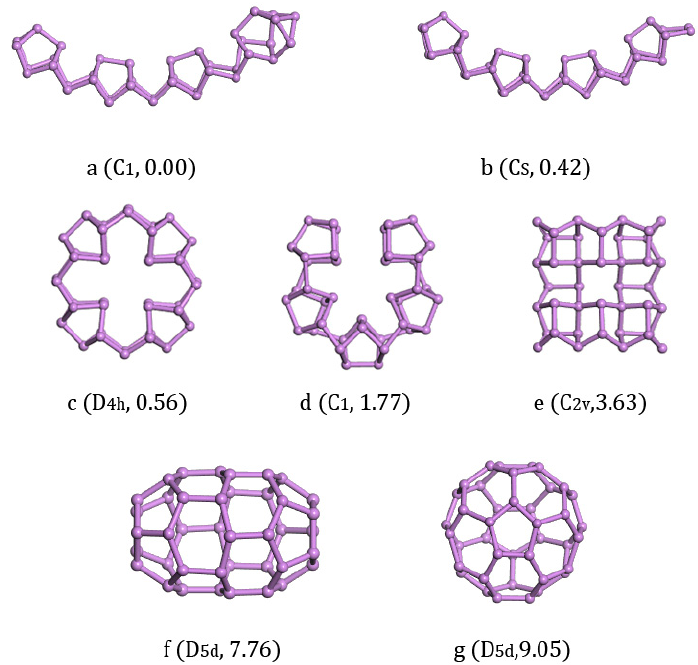
Figure 6. Lowest-energy and isomorphic structures for As 40 clusters. The relative total energies are in eV.